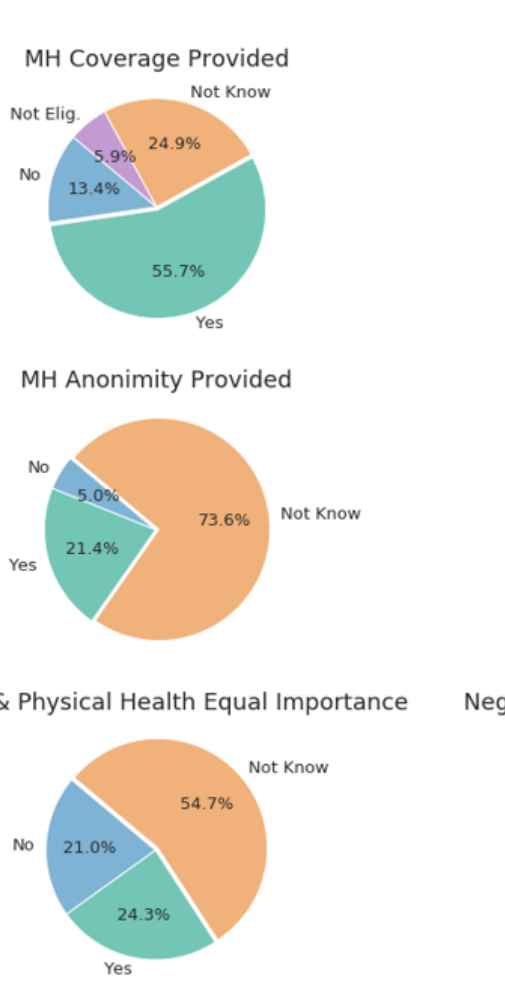
Figure 8: MH considerations by Companies